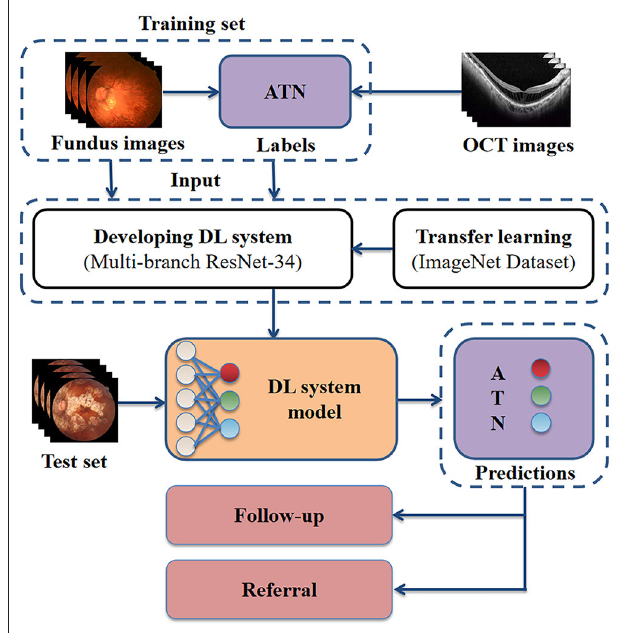
FIGURE 1 | Schematic representation of our approach for developing a high myopia predictive model. Retinal specialists labeled each fundus photograph according to the corresponding OCT images. The fundus photographs with ground true labels were used for model training. For clinical application, the model receives as input fundus photographs, then outputs the predicted ATN classification. OCT, optical coherence tomography; DL, deep learning; A, atrophy; T, traction; N,